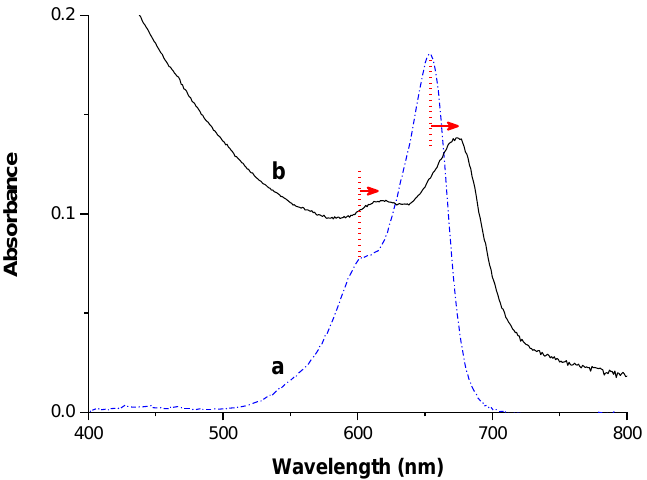
Figure 6. Visible spectra of C.I. Basic Blue 3 at a dye loading of 1.2 10 − 3 g L − 1 in the absence ( a ) and presence ( b ) of potassium humate.